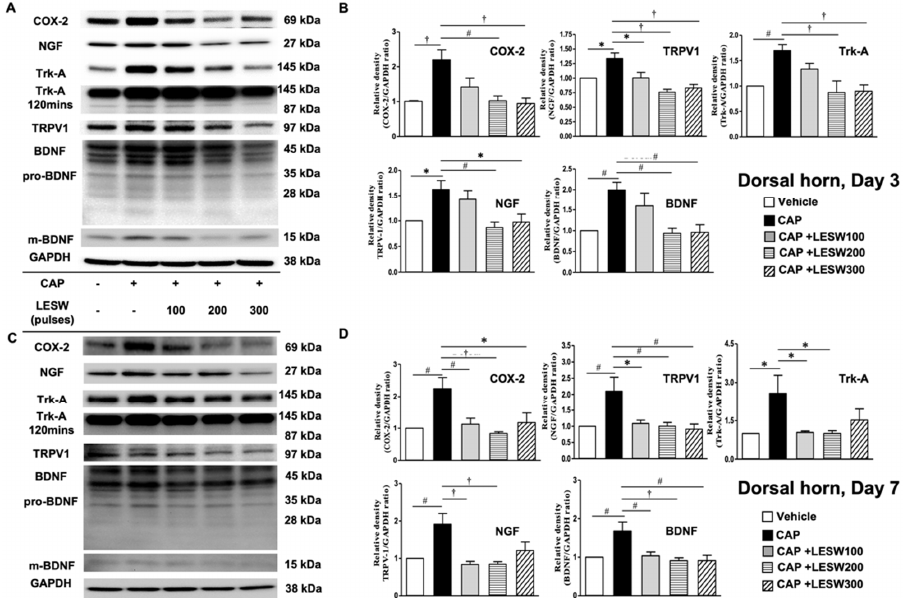
Figure 5. ( A , C ) Western blot for COX-2, NGF, Trk-A, BDNF, and TRPV1 expression in the dorsal horn of L6 spinal cord on day 3 and day 7 after intraprostatic capsaicin injection. ( B , D ) Capsaicin injection increased COX-2, NGF, Trk-A, BDNF, and TRPV1 expression (solid black bar) on day three and day seven in the L6 spinal cord. In total, 200 and 300 shocks of Li-ESWT significantly suppressed expression of inflammatory molecules, neurogenic growth factors and receptor expression on day three after treatment. By day seven, all shock wave treatment groups showed significant downregulation of the COX-2, TRPV1 and BDNF expression, while only 100 and 200 shocks of Li-ESWT significantly decreased NGF and Trk-A expression. ( n = 10 per group; * p < 0.05; # p < 0.01; † p < 0.001).